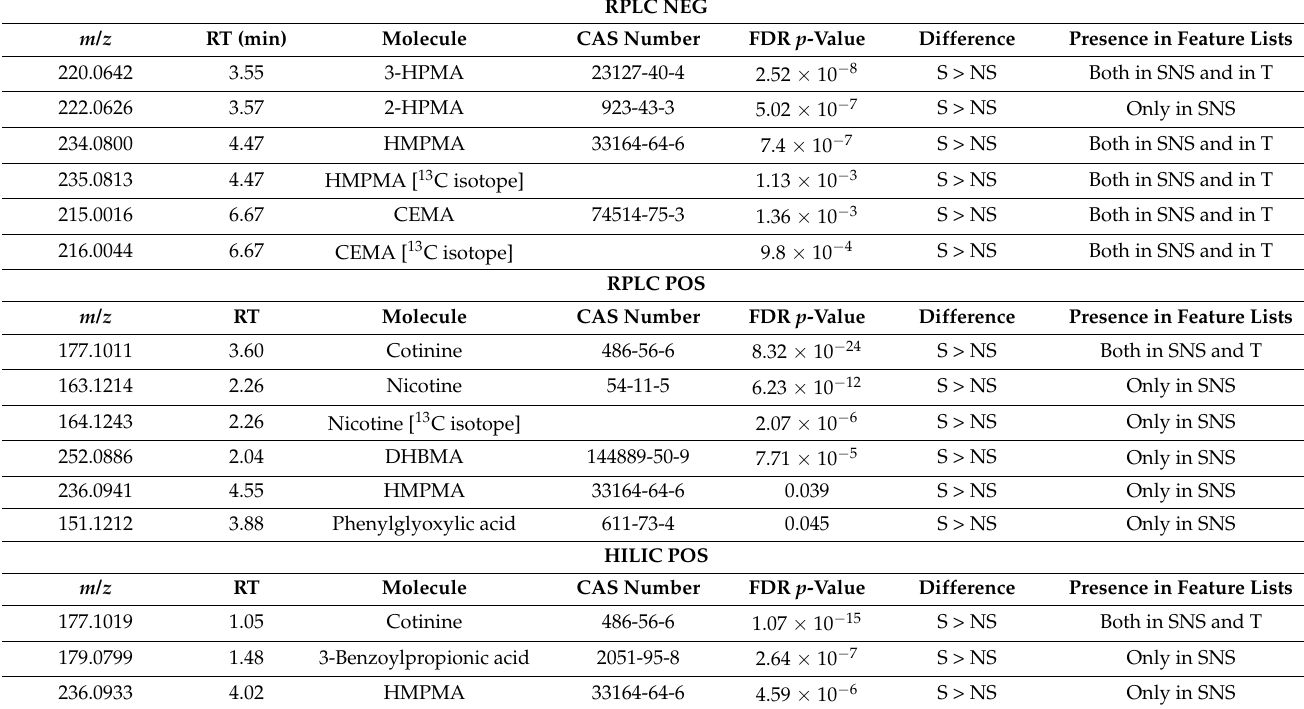
Table 1. List of confidentially identified features, for each chromatographic run: RPLC NEG (out of 98 significant features), RPLC POS (out of 76 significant features), and HILIC POS (out of 48 significant features). No compounds were confidently identified in HILIC NEG (out of 12 significant features). For each feature, the mass-to-charge ( m/z ) ratio, retention time (RT), and CAS number are reported, along with the FDR p -value of the t -test, in which group of subjects the compound was higher (smokers, S, or non-smokers, NS), and in which feature lists that feature was present.